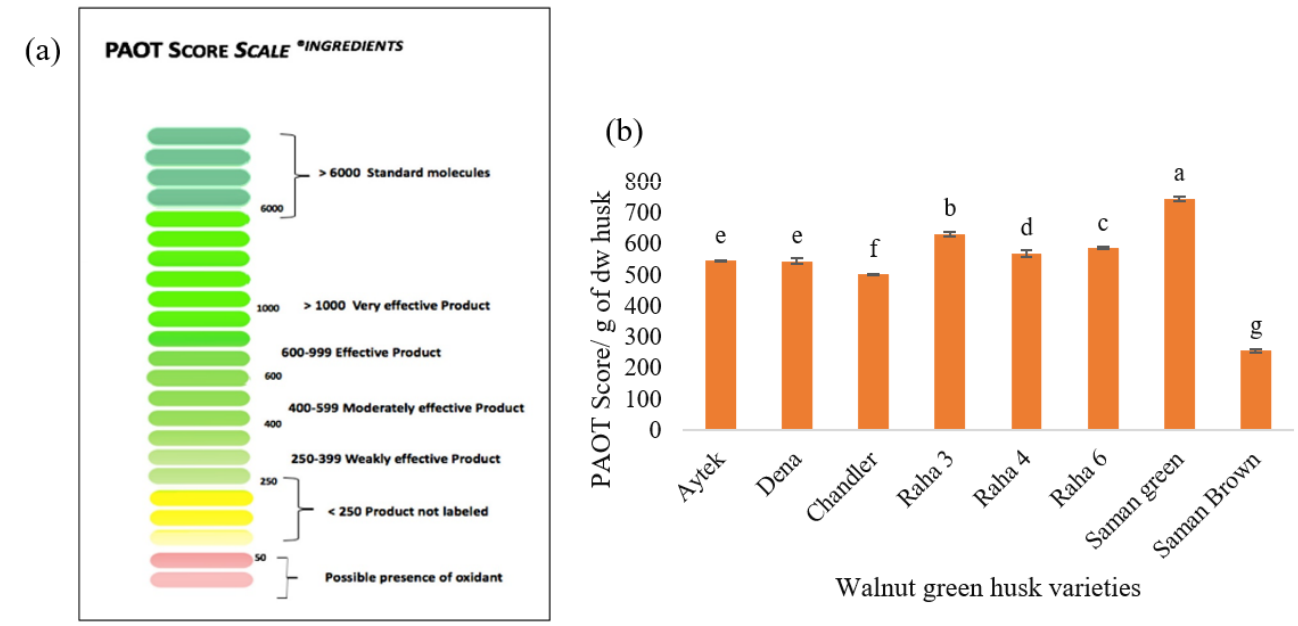
Figure 3. ( a ) PAOT liquid technology scale (ingredients), and ( b ) values of total antioxidant power of dried green walnut husk powder expressed with PAOT score/g of product.